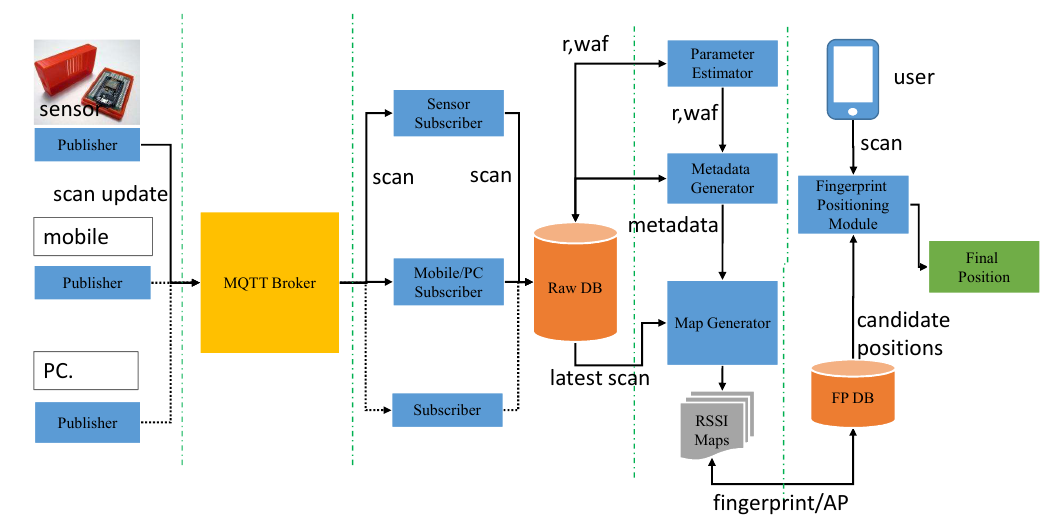
Figure 11. System flow diagram.